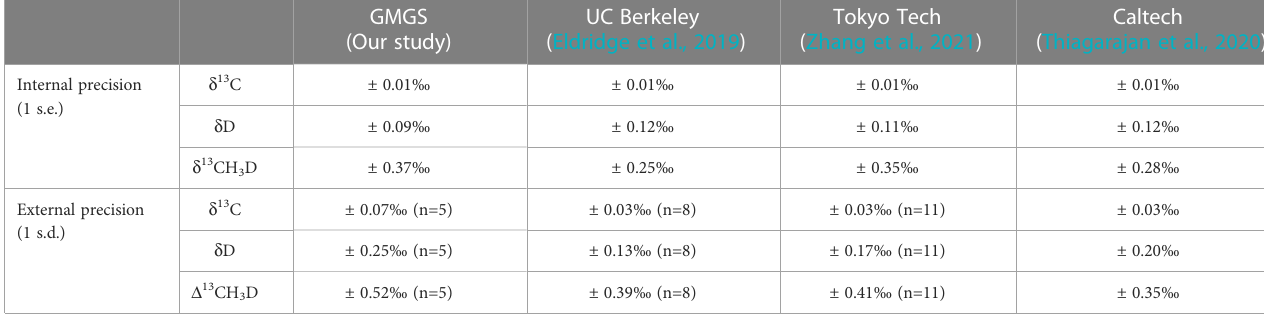
GMGS UC Berkeley (Our study) (Eldridge et al., 2019)